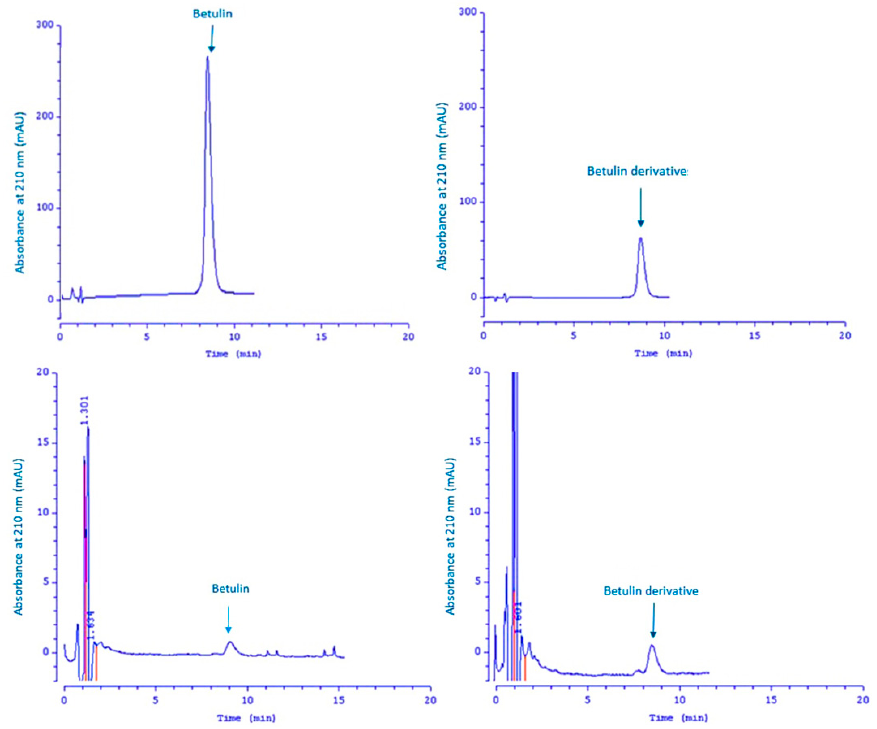
Figure 3. HPLC chromatograms of reference betulin and reference compound 8 (above), HPLC chromatograms of betulin and betulin derivative 8 in the acceptor fluid after a 24 h experiment (below).